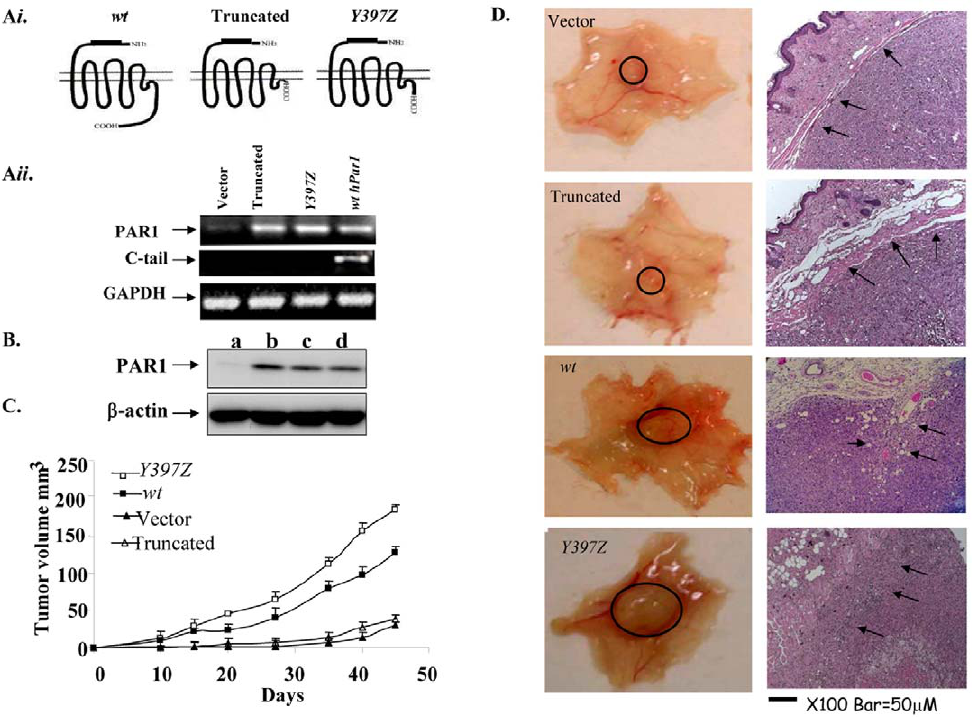
Figure 1. PAR1 enhances tumor growth and angiogenesis in a xenograft mouse model. A i. Schematic representation of the hPar1 constructs. wt hPar1 , truncated hPar1 (devoid of the cytoplasmic tail), Y397Z hPar1 (shorter C-tail of persistent signaling). A ii. Semi-quantitative RT-PCR analysis of various hPar1 constructs. RT-PCR analysis of cells transfected with wt hPar1 , Y397Z hPar1 , truncated hPar1 or empty vector using primers to PAR 1 N-terminus (upper panel), C-terminus (middle panel), or GAPDH (lower panel). PAR 1 N-terminus primers were as follows: hPar1 -sense: 5 9 - CTCGTCCTCAAGGAGCAAAC-3 9 , antisense orientation: 5 9 -TGGGATCGGAACTTTCTTTG-3’ (564-bp PCR product). PAR 1 C-tail primers – sense: 5 9 -TAC TAT TAC GCT GGA TCC TCT GAG-3 9 and antisense: 5 9 -CTT GAA TTC CTA AGT TAA CAGCTT-3 9 . These primers give rise to a 181-bp product corresponding to the entire PAR 1 C-tail site, as follows: YY – YASSECQRYVYSILCCKESSDPSYNSSGQLMASKMDTCSSNLNNSIYKKLLT. B . Western blot analyses of MCF7 cells expressing various hPar1 constructs. a. Mock-transfected MCF7; b. Y397Z hPar1 ; c. Truncated hPar1 ; d. wt hPar1 . C. Mouse mammary tumor growth in animals implanted with cells expressing wt hPar1 and variants. MCF7 cells expressing various hPar1 were inoculated into the mammary pads of mice. Tumor volumes (mean 6 SD) are shown for wt hPar1 ( & ), Y397Z hPar1 ( % ), truncated hPar1 ( D ), and empty vector ( m ; tumor volume 30 6 3 mm 3 ) (* P , 0.005). D . Morphological appearance. The Y397Z hPar1 and wt hPar1 constructs exhibited intense vascularization and appeared reddish as opposed to the pale appearance of tumors generated by either empty vector or truncated hPar1 . Tissue sections of tumors were stained with H&E (right panels). Magnification is 6 100.